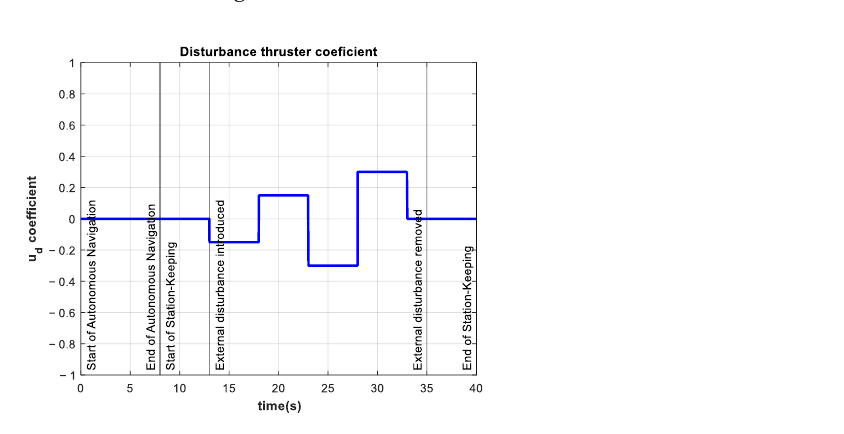
Some experiments were performed with time-varying external disturbances, such as the one shown in Figure 19.